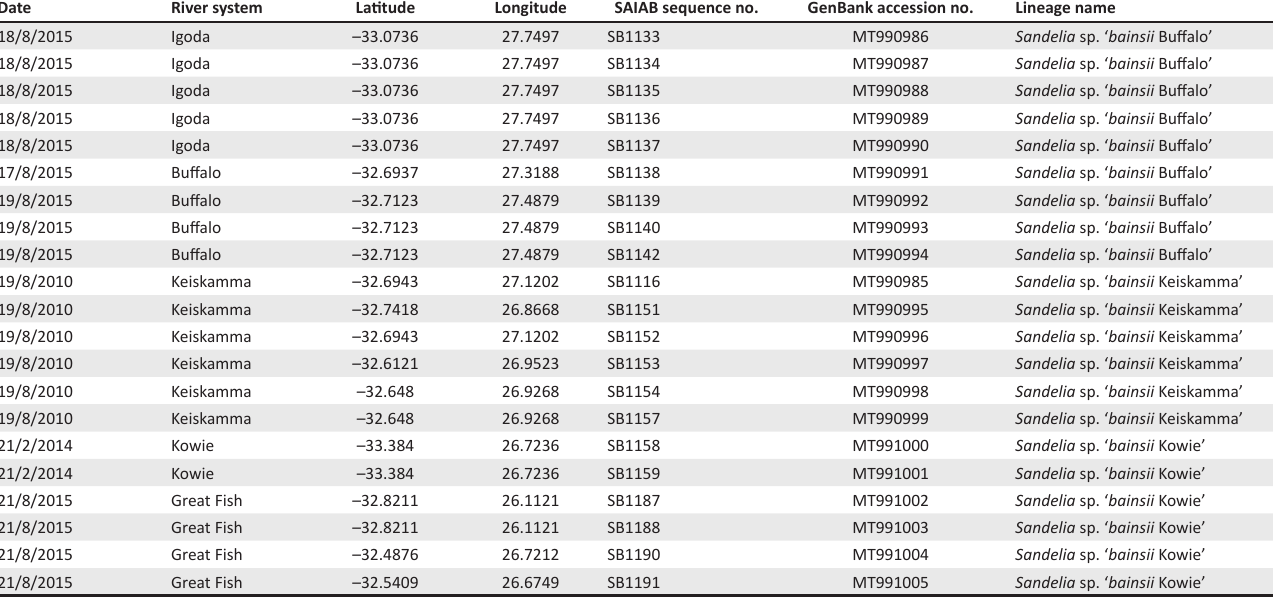
TABLE 1: Sequence numbers and locality details for the lineages identified within Sandelia bainsii